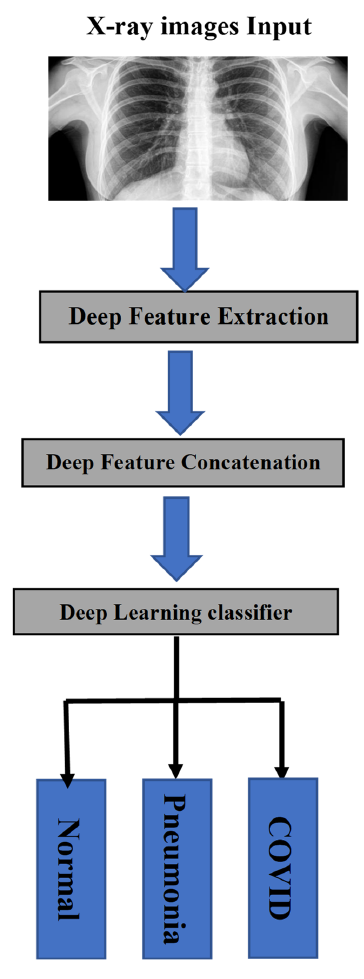
Figure 3. Simple block diagram of the proposed system.